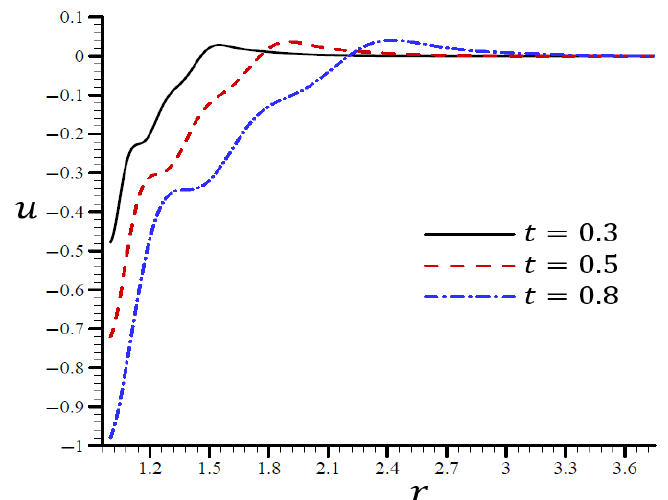
Figure 9. The influence of 𝑡 on radial displacement 𝑢 through the radial direction of the spherical hole using the RTPL model.